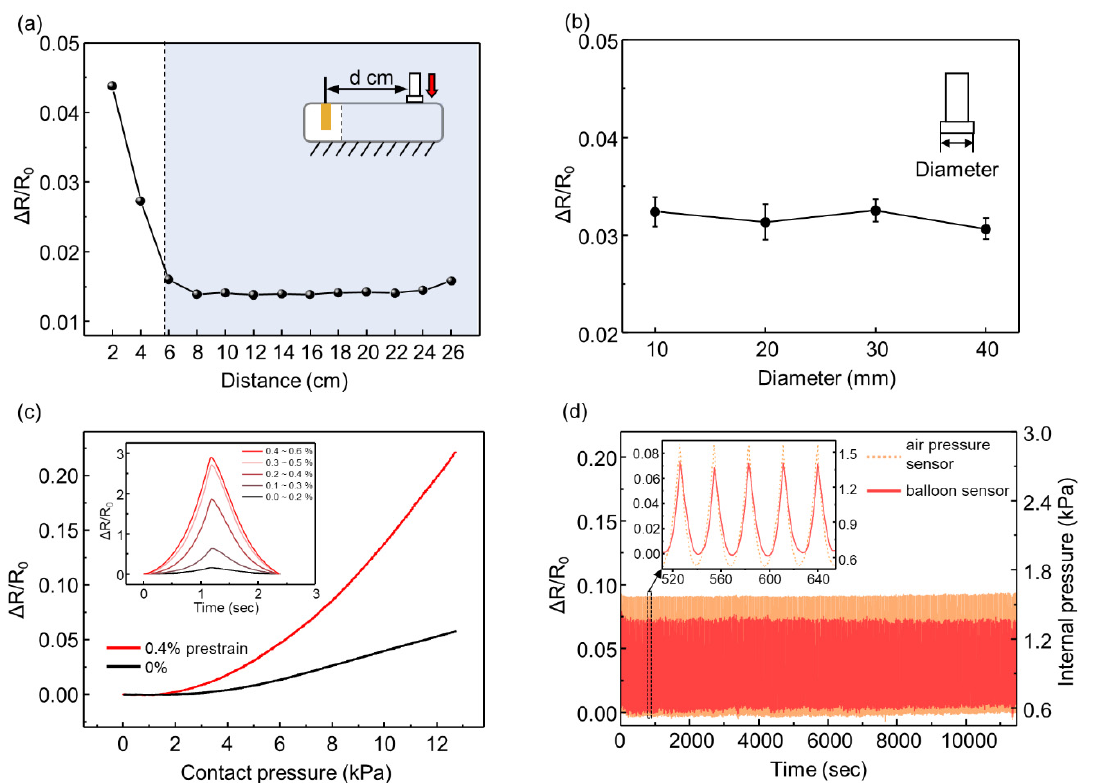
Figure 5. ( a ) Relative changes in the resistance of the balloon sensor for different locations of applied force; ( b ) relative changes in the resistance for different areas of the indenter; ( c ) relative changes in the resistance as a function of contact pressure with a pre-stretched strain sensor and not-stretched sensor; ( d ) response of the strain sensor integrated with the balloon sensor and internal pressure of the balloon for a cyclic test.